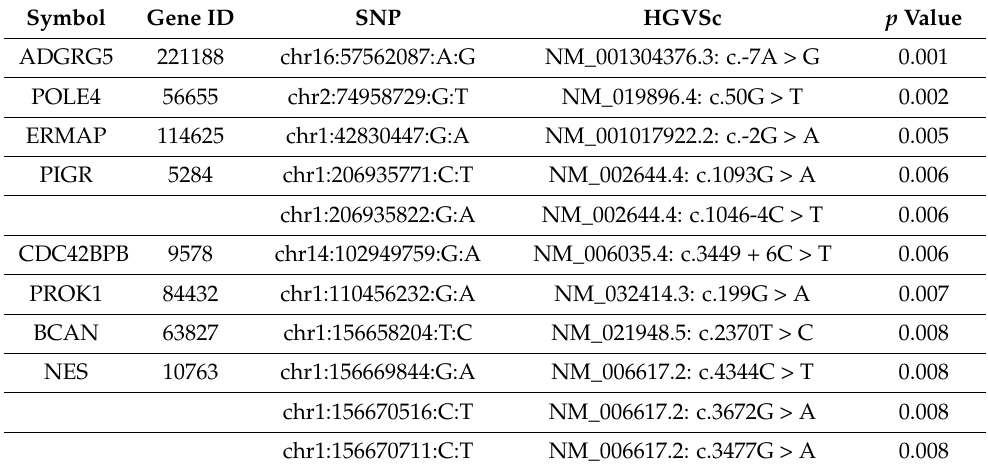
Table 5. The genome wide association study (GWAS) analysis of the proband and control